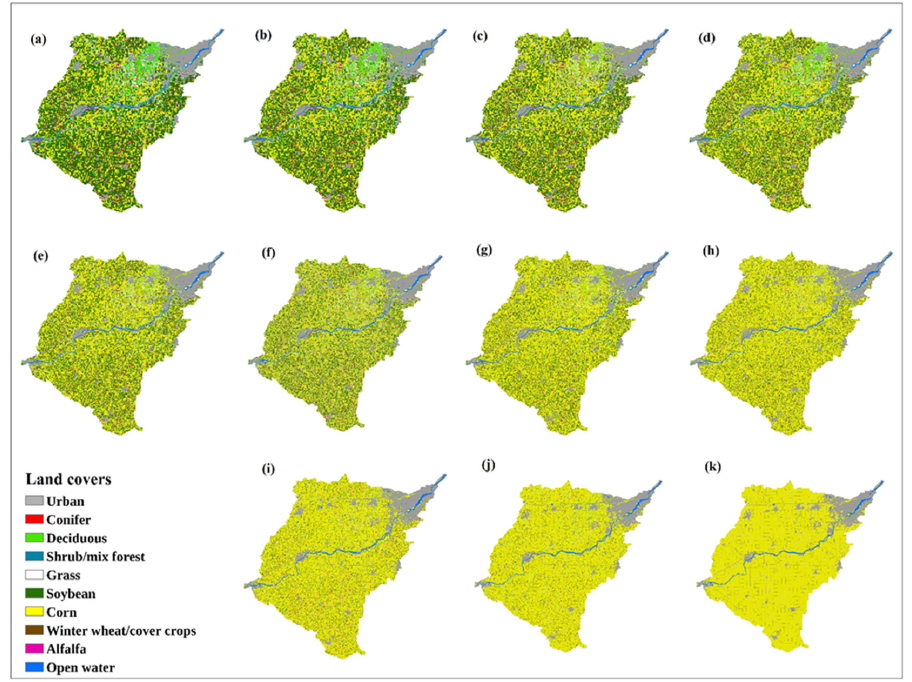
Figure 10. Land cover images used in ET simulations under different percentages of corn cover: ( a ) Original (reclassified) LULC image of the study area (USDA LULC, 2018), ( b – k ) images with 10% incremental changes of vegetation cover, until it is 100% covered with corn.